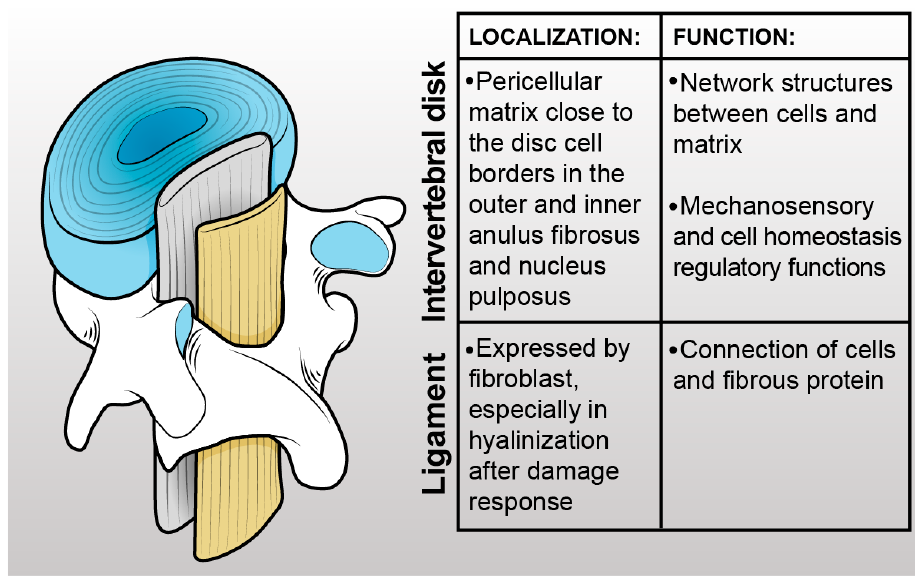
Figure 2. The role of collagen VI in different tissues: Intervertebral disk and Ligament .